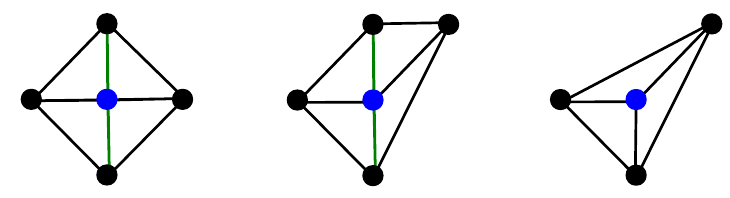
Figure 1 . Toric diagrams for SU(2) 0 , SU(2) (cid:25) and P 2 theory (which is obtained from SU(2) (cid:25) by an external (cid:13)op). The internal vertex (blue) indicates the Cartan of the rank one gauge group, the external vertices correspond to non-compact divisors. Whenever there is a ruling, i.e. a partial singularization to an A 1 singularity, this is indicated by a green